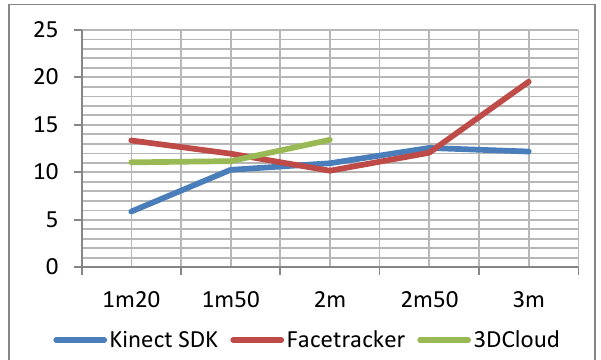
Figure 18. Mean RMSE (in degrees) for the pitch function of the viewer distance from TV (in m).